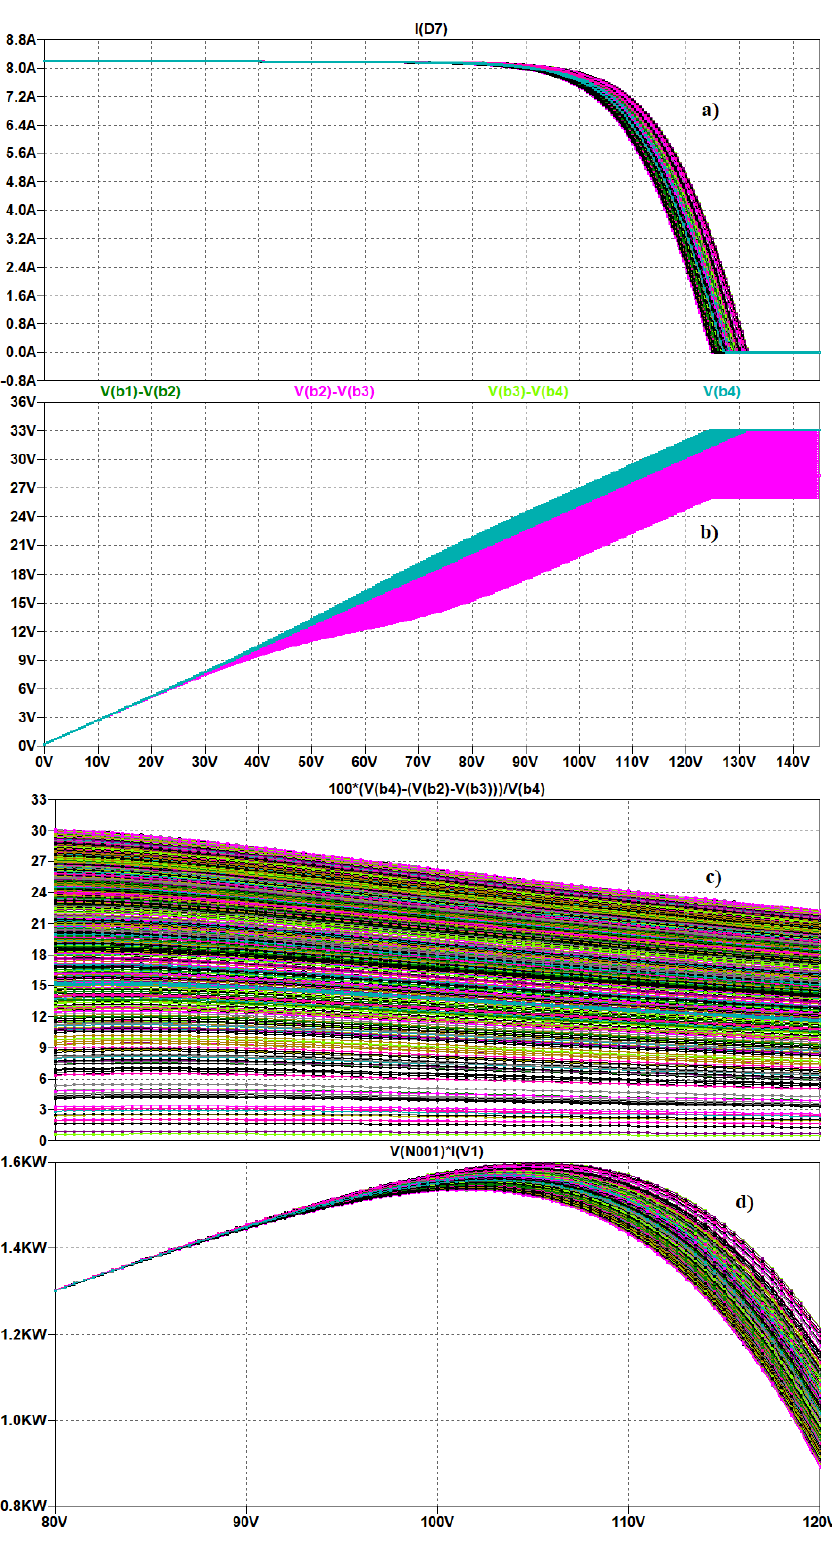
Figure A6. Light induced degradation faults. This figure shows four charts as follows: ( a ) the current of the affected string versus the operation voltage of the array, ( b ) the differential voltage for all the modules in the affected string, ( c ) the relative percentage difference versus the operating voltage of the array, ( d ) peak behavior of output power in the